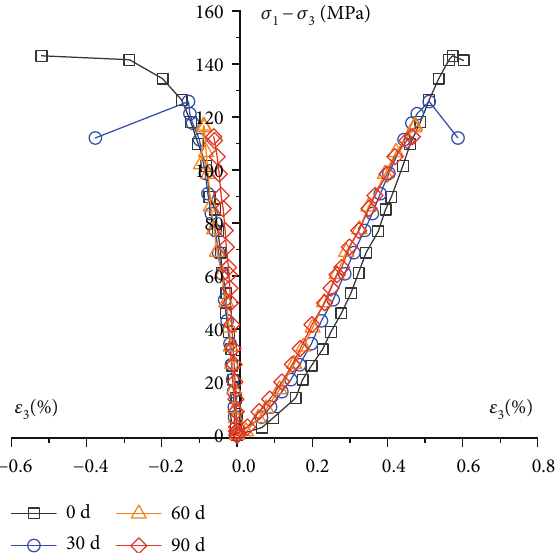
Figure 8: Stress-strain curves of fi ssured granites of uniaxial compression test under the action of chemical corrosion ( α = 0 ° specimen after chemical corrosion for 30, 60, and 90 days).